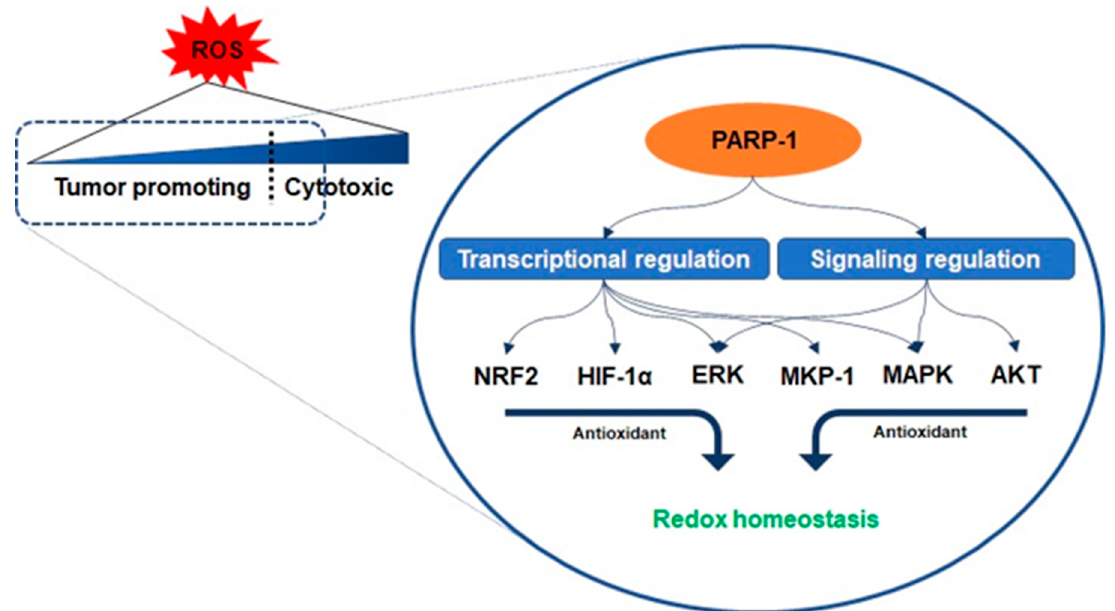
Figure 3. Regulation of redox homeostasis by PARP-1. The activity of PARP-1 plays an important role in the adaptive response of cancer cells to oxidative stress. PARP-1 promotes the interaction of antioxidant response elements with nuclear factor erythroid-related factor 2 (NRF2) and interacts with hypoxia-inducing factor 1-alpha (HIF1- α ). PARP-1 activation and poly ADP ribose synthesis possibly modulate the mTOR complex 2, resulting in AKT downregulation to inhibit oxidants’ accumulation. To regulate oxidants level, PARP-1 is in charge of the transcription of the extracellular signal-regulated kinase (ERK) and mitogen-activated protein kinase phosphatase 1 (MKP-1) related to mitogen-activated protein kinase (MAPK) regulation.